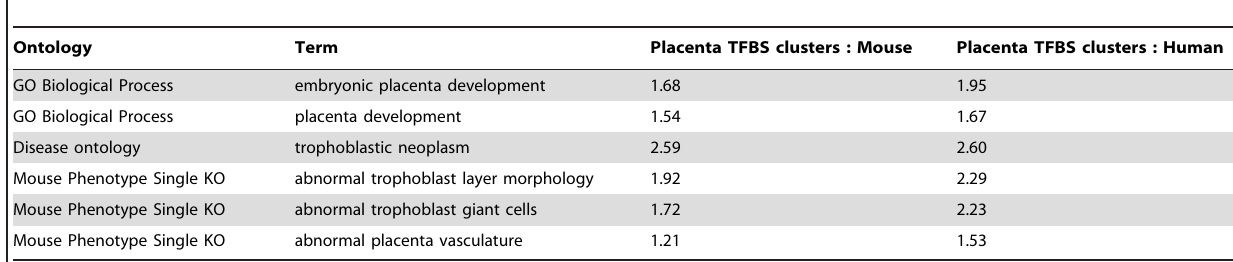
Figure 5. Overlap with large-scale experimental data. Overlap of placenta TFBS clusters with mouse placenta enhancer-associated ChIP-Seq data (A) and human placenta DNase-Seq data (B). Placenta TFBS clusters had a significant overlap with both the mouse (C) and human (D) experimental data. (E) Each dataset had a large proportion of regions that were not identified in the other two datasets. Over 800 placenta TFBS clusters were not found in either the mouse or human experimental data. Counts for human data are after conversion to mouse mm9. doi:10.1371/journal.pcbi.1003449.g005 Table 2. Fraction of unique placenta TFBS clusters associated with placenta terms compared to placenta experimental